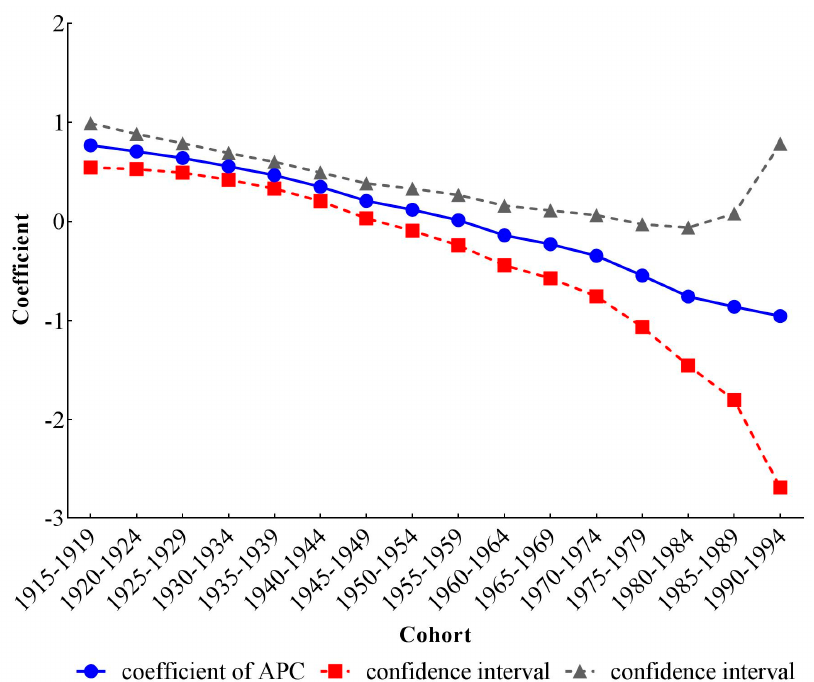
Figure 7. Cohort effects on stroke mortality PM 2.5 in China.